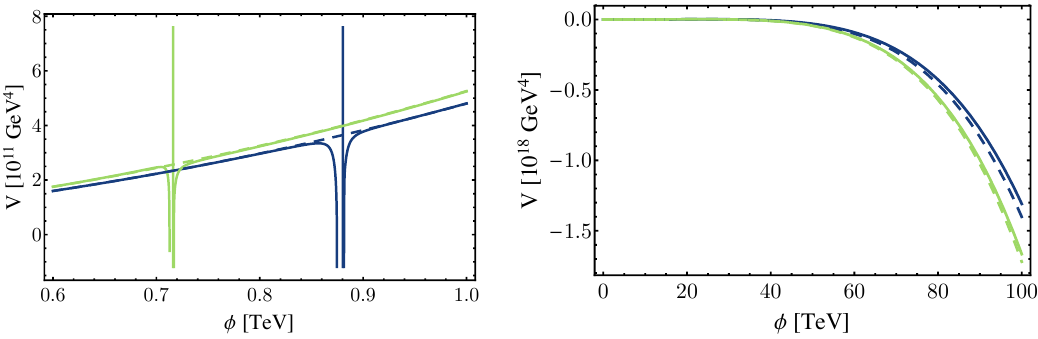
Figure 6 . Potential as a function of (cid:30) obtained using di(cid:11)erent methods of RG-improvement for two di(cid:11)erent reference scales, (cid:22) 0 = 246 GeV (dark blue) and (cid:22) 0 = 10 4 GeV (green). Solid lines correspond to the tree-level potential evaluated at t (0) (cid:3) (see eq. (3.15)), while dashed curves correspond to the one-loop e(cid:11)ective potential evaluated at the scale log (cid:30) ~ (cid:22) 0